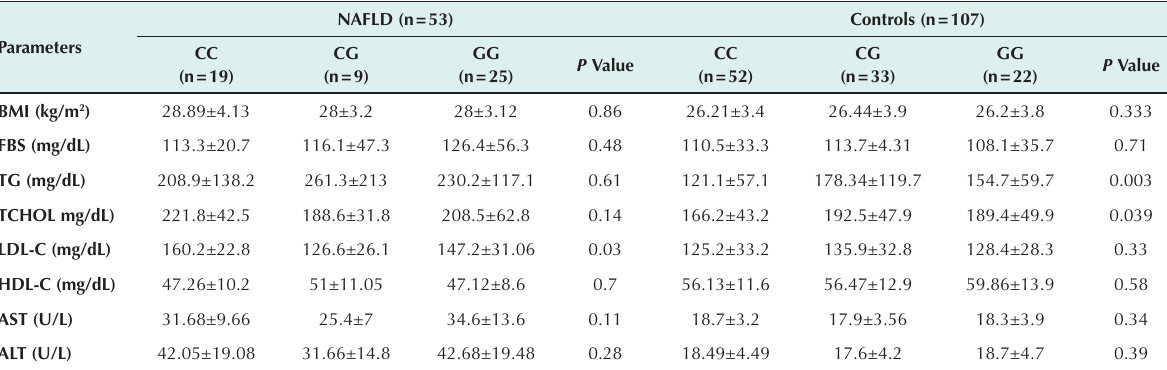
Table 4. Comparison of Quantitative Variables Between Three Genotypes of the PNPLA3 rs738409 SNP Among NAFLD Patients and Controls